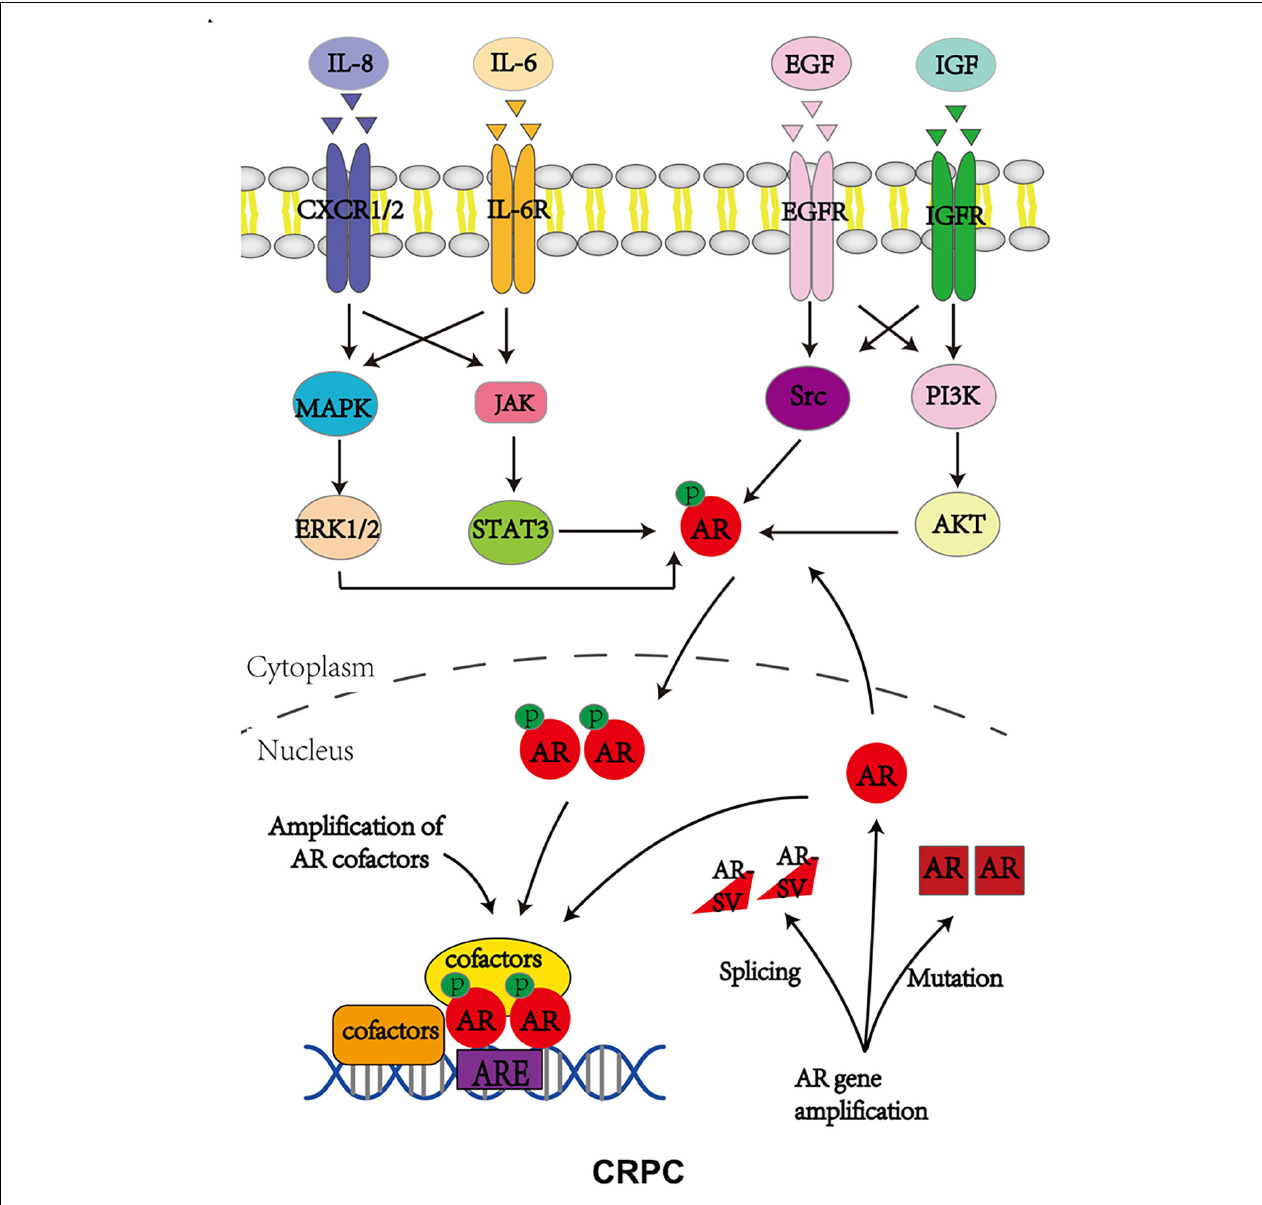
FIGURE 2 | Androgen receptor utilizes various ways to bypass AR inhibition to support CRPC growth. P stands for